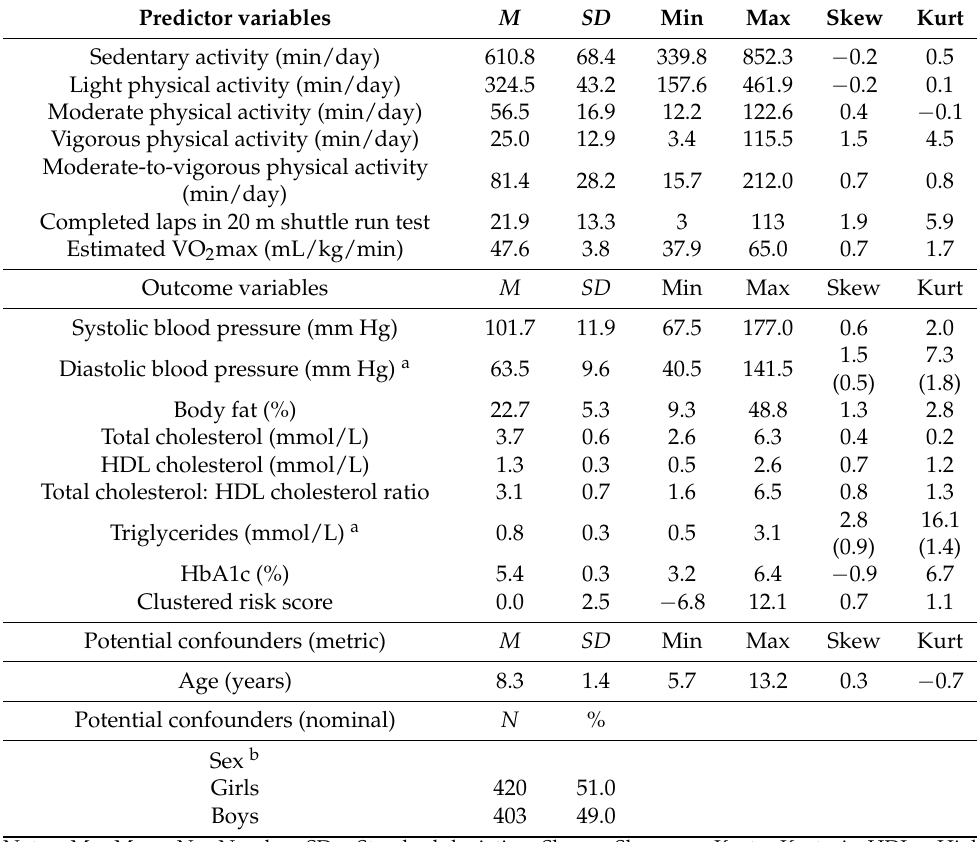
Table 1. Descriptive statistics of all study variables, for the total sample ( N =